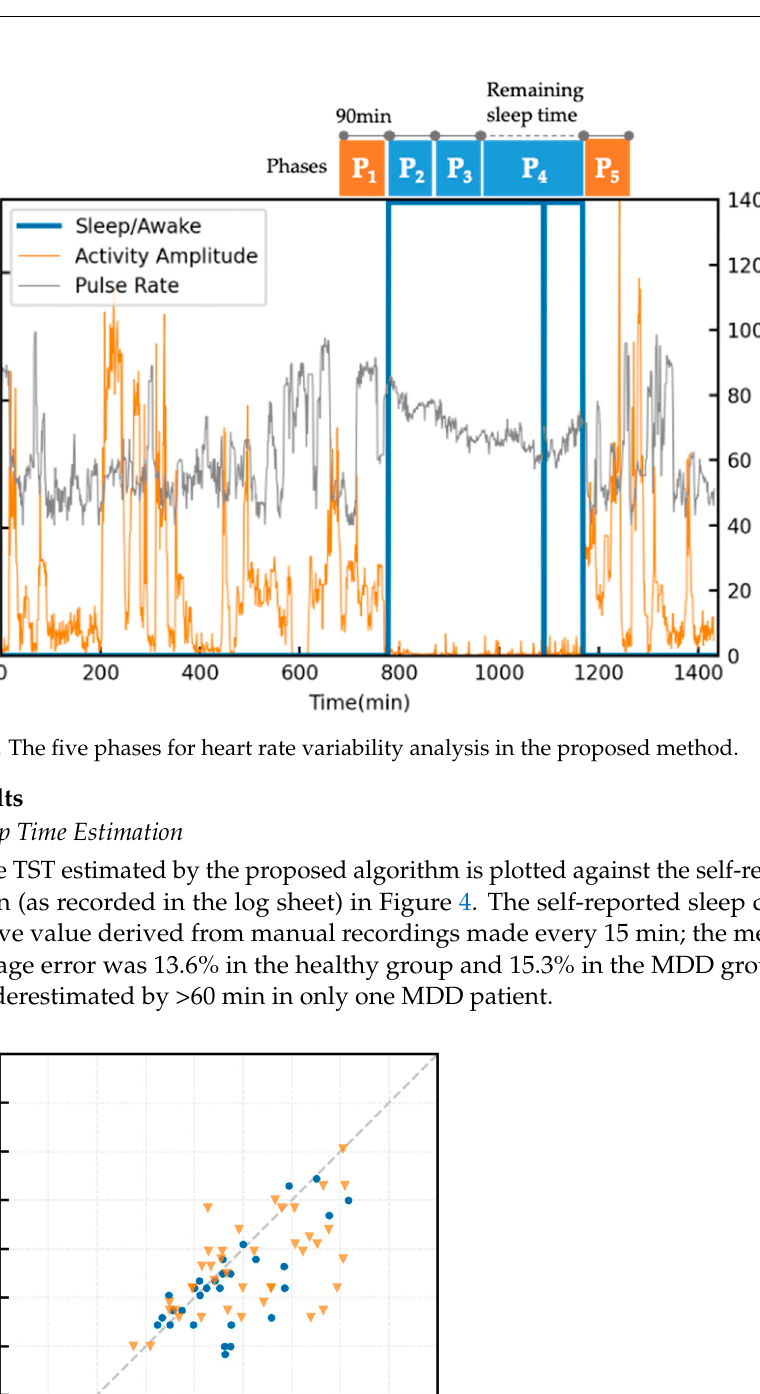
Table 3. Percentages of data remaining and computer processing unit time after thresholding using signal quality indices in the frequency domain. Total